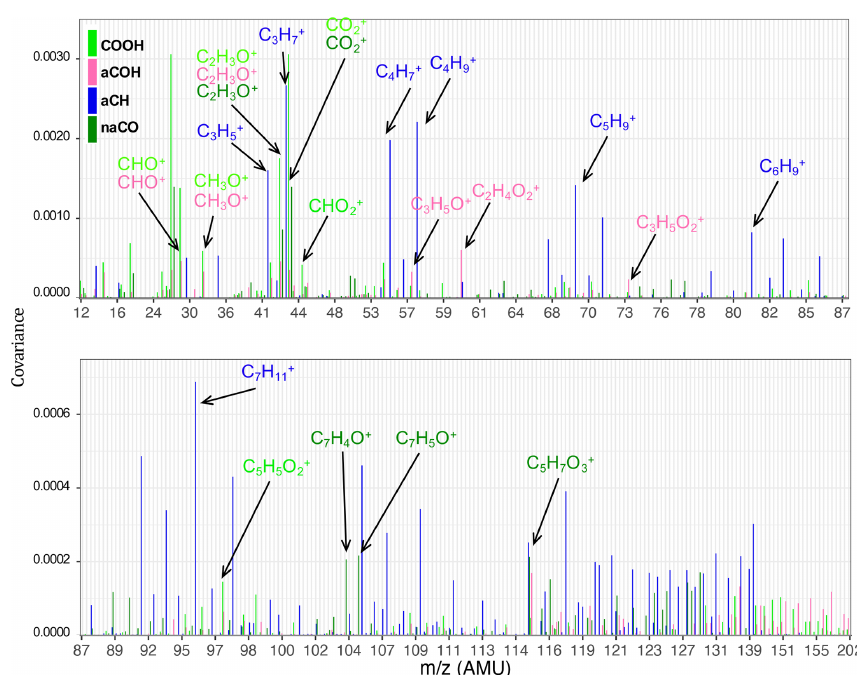
Figure 5. Bar plots showing positive covariances of normalized AMS fragment ion concentrations and normalized functional group abun- dances.